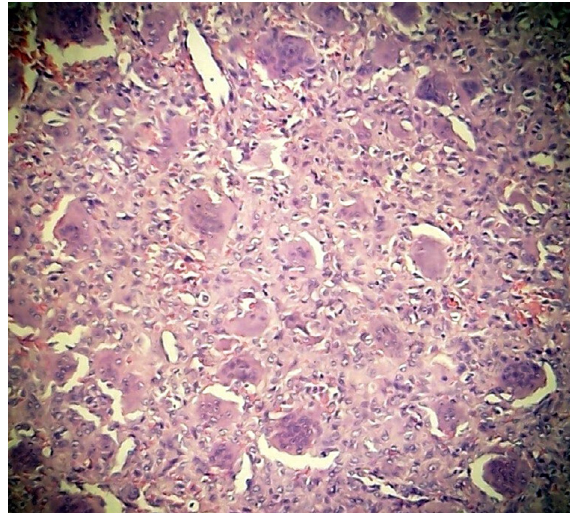
Figure 2. Histological photomicrograph (hematoxylin-eosin stain) of the biopsy specimen.